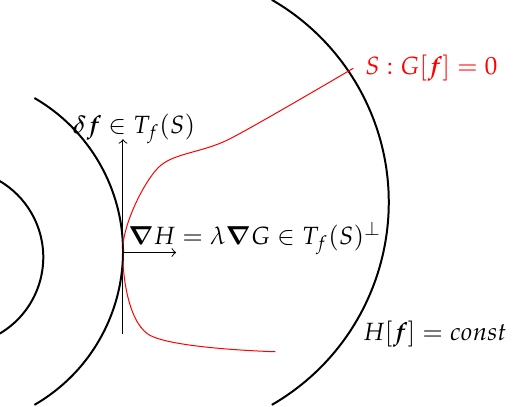
Figure 1. Contour lines of the function H [ f ] , the constraints surface S : G [ f ] = 0, the elements of the tangent spaces T f ( S ) , and the complement to the tangent space T f ( S ) ⊥ are